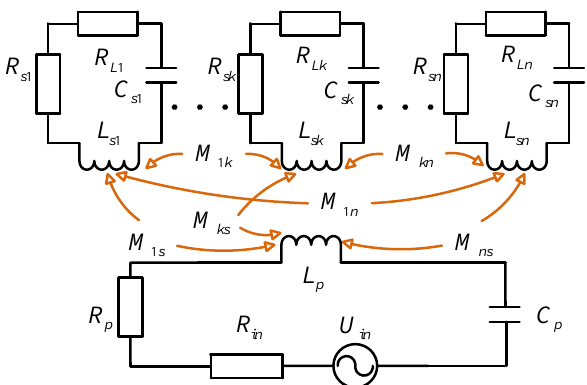
Figure 3. The circuit model of proposed opportunity EV wireless charging system.